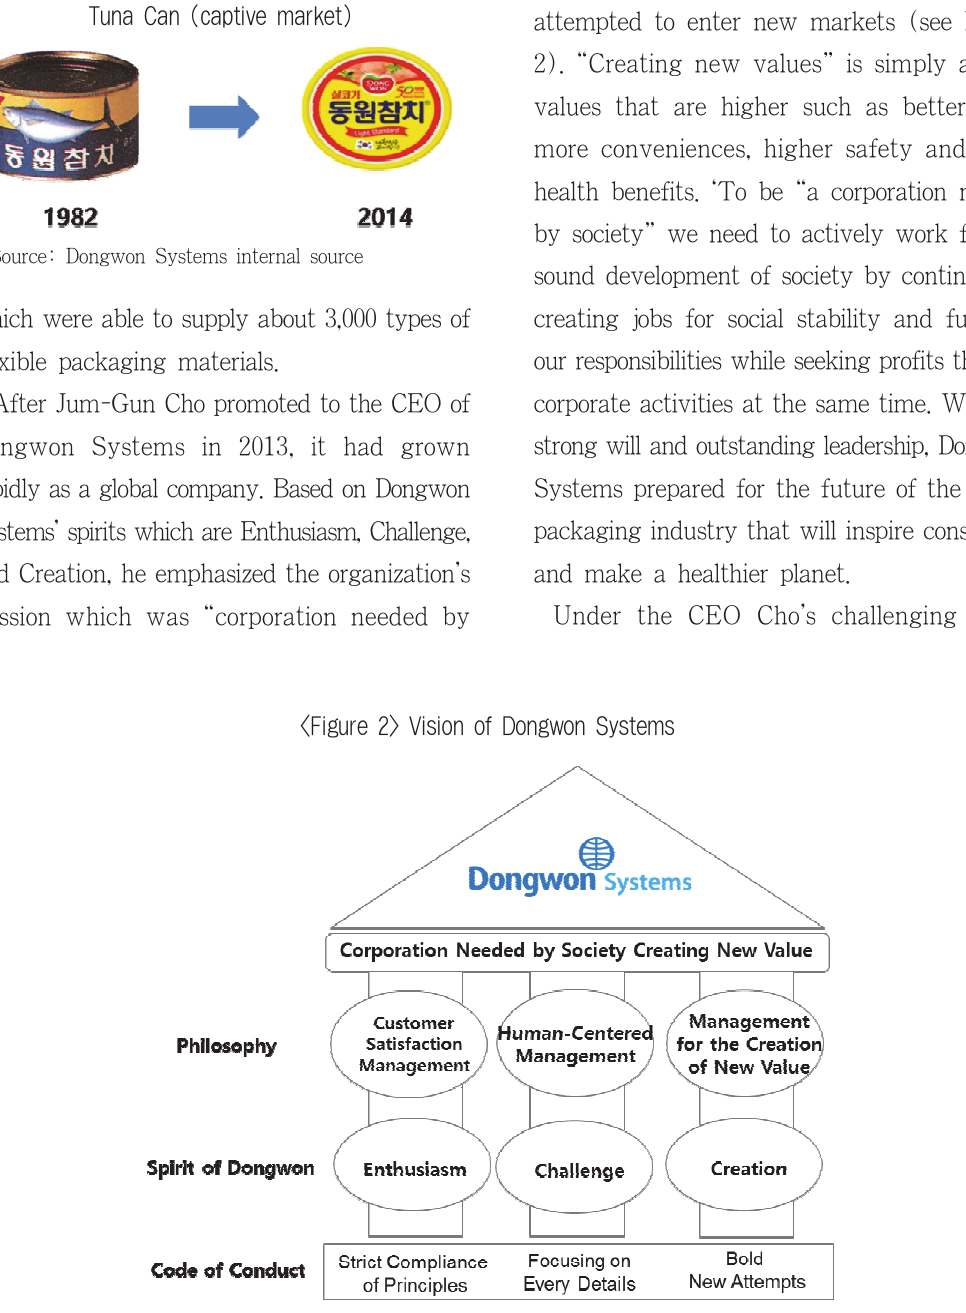
<Figure 1> Dongwon System’s First Product: Tuna Can (captive